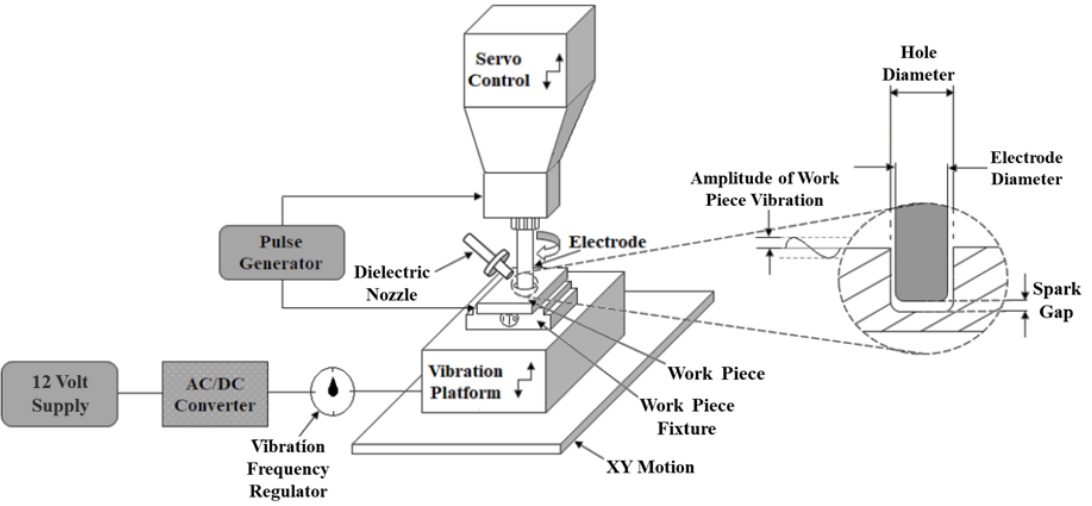
Figure 3. Schematic of Vibration-Assisted Die-Sink EDM.